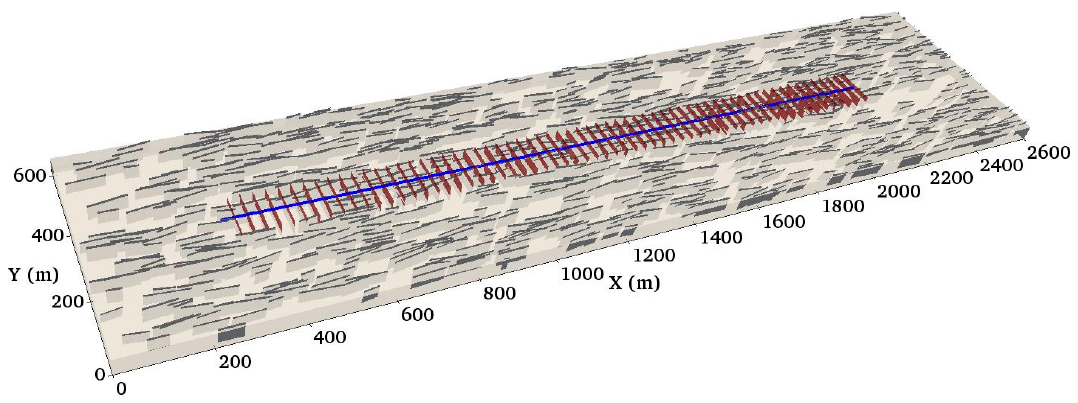
Figure 2. Numerical model with hydraulic fractures (in red) and natural fractures (in grey).